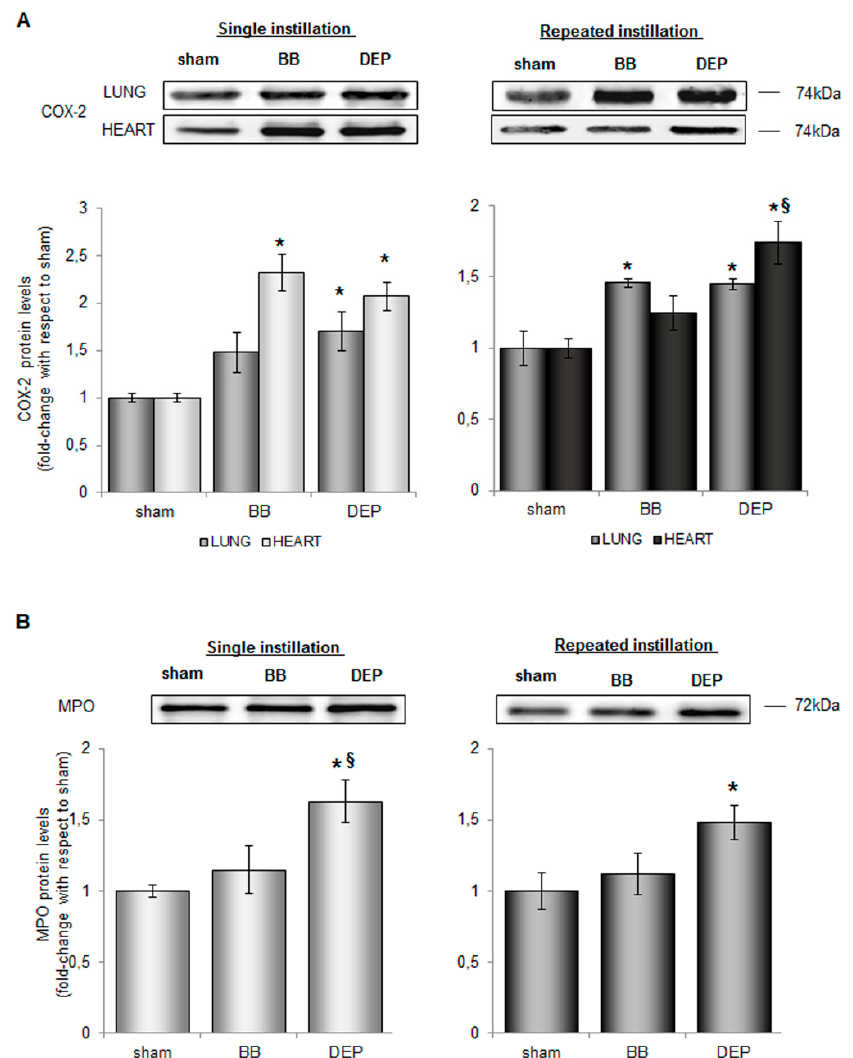
Figure 4. Inflammatory markers protein levels in lung and heart parenchyma. Representative immunoblotting images of COX2 analysis in mice lung and heart ( A ) and of MPO in heart parenchyma ( B ) after single and repeated instillations with 50 µ g of BB or DEP / 100 µ L 0.9% NaCl. Histograms display COX2 and MPO as fold-change with respect to sham. Proteins have been normalized for corresponding total proteins revealed by Ponceau staining in each lane and the data are expressed as mean ± standard error ( n = 6). Statistical di ff erences were tested accordingly by One-way ANOVA followed by Bonferroni post-hoc comparison. * p < 0.05 vs. sham mice; § p < 0.05 vs. BB.